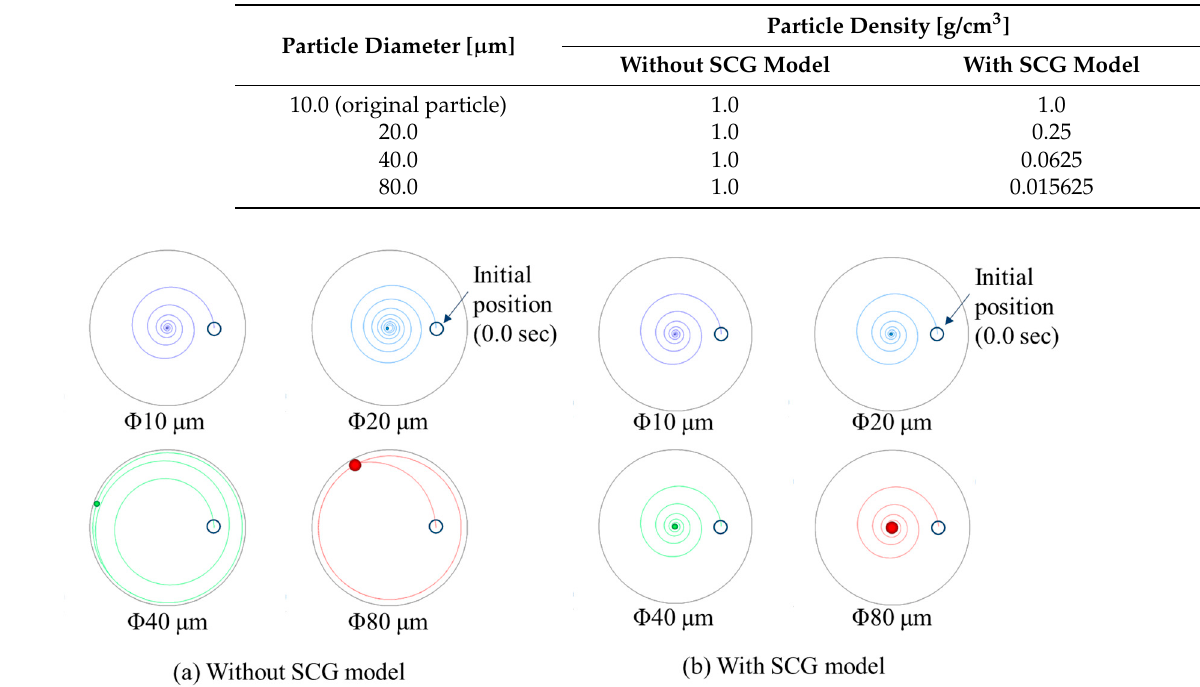
Figure 5. Comparison of the particle trajectories from 0.0 to 3.0 s on vortex flow field represented by DEM with and without the SCG model.